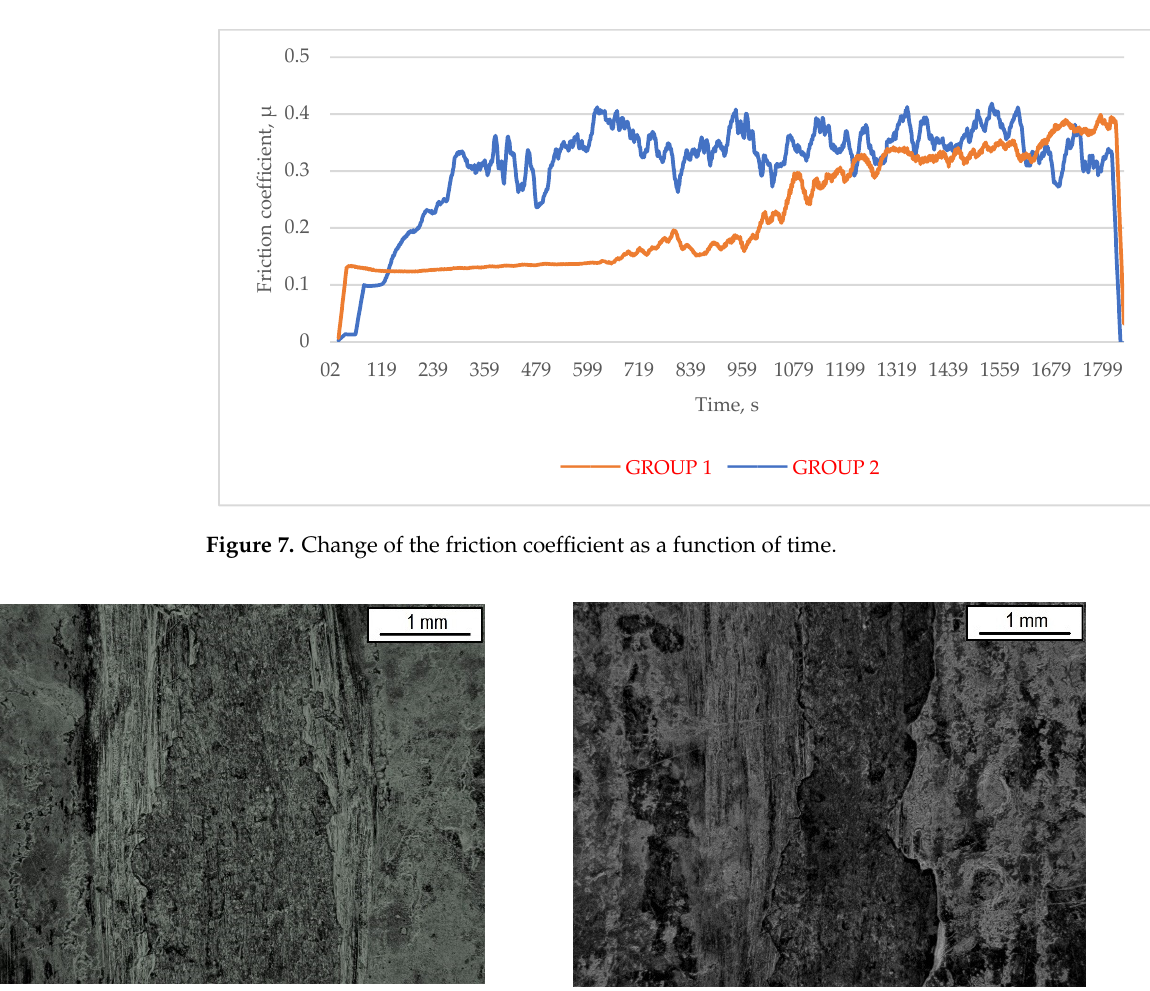
Figure 7. Change of the friction coefficient as a function of time.